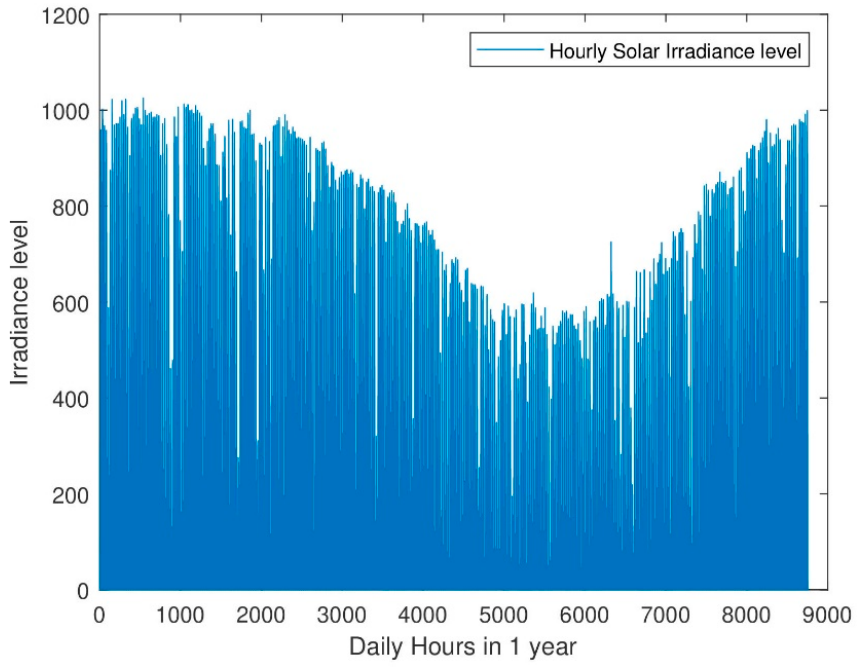
Figure 10. Solar Irradiance data set.